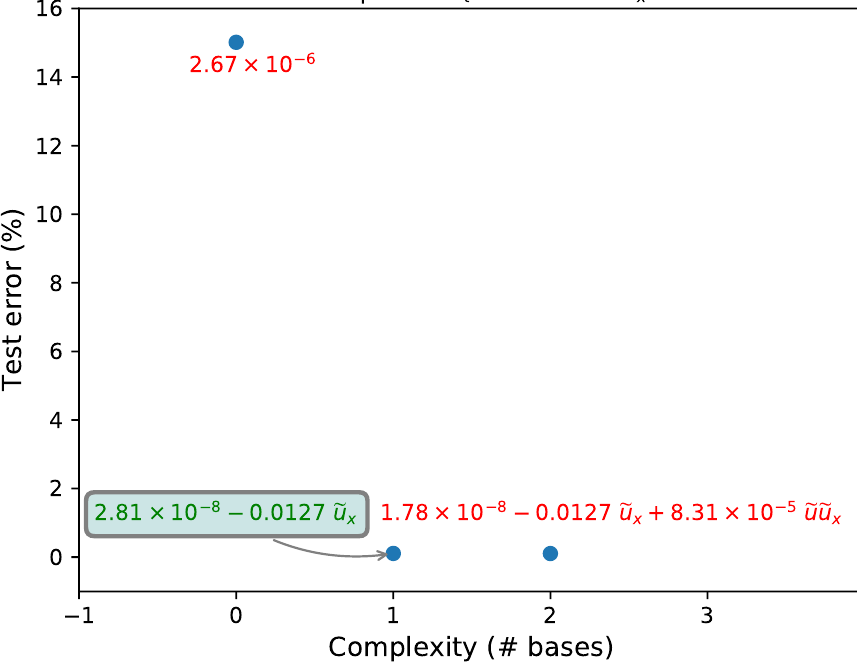
Figure 11. Predicted wave equation rather the intended Kawahara equation as the input data satisfies both PDEs. FFX identifies the sparser (lesser bases) model which is the wave equation.